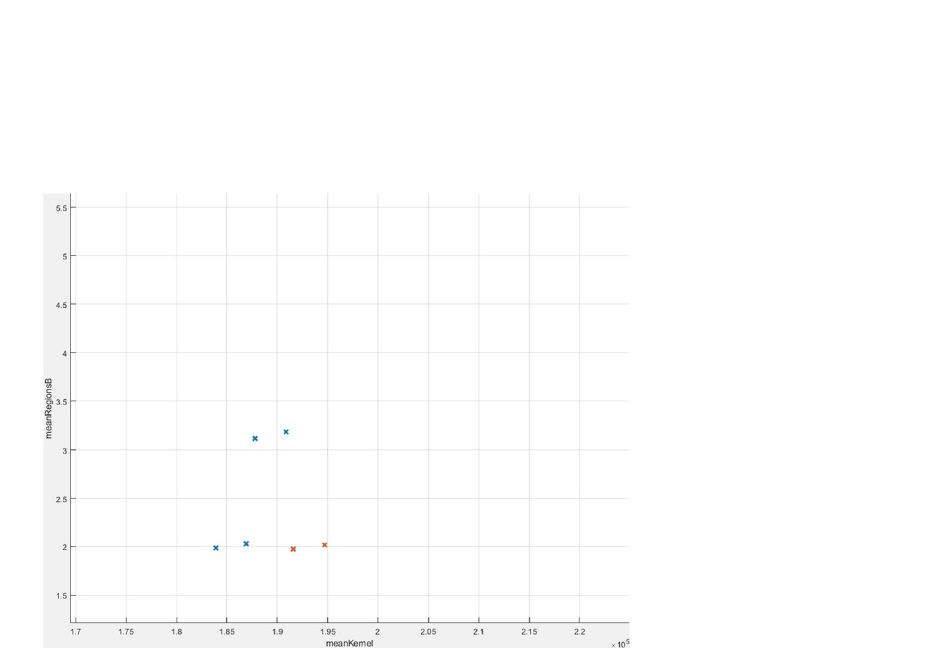
Figure 23. Wrong analysed